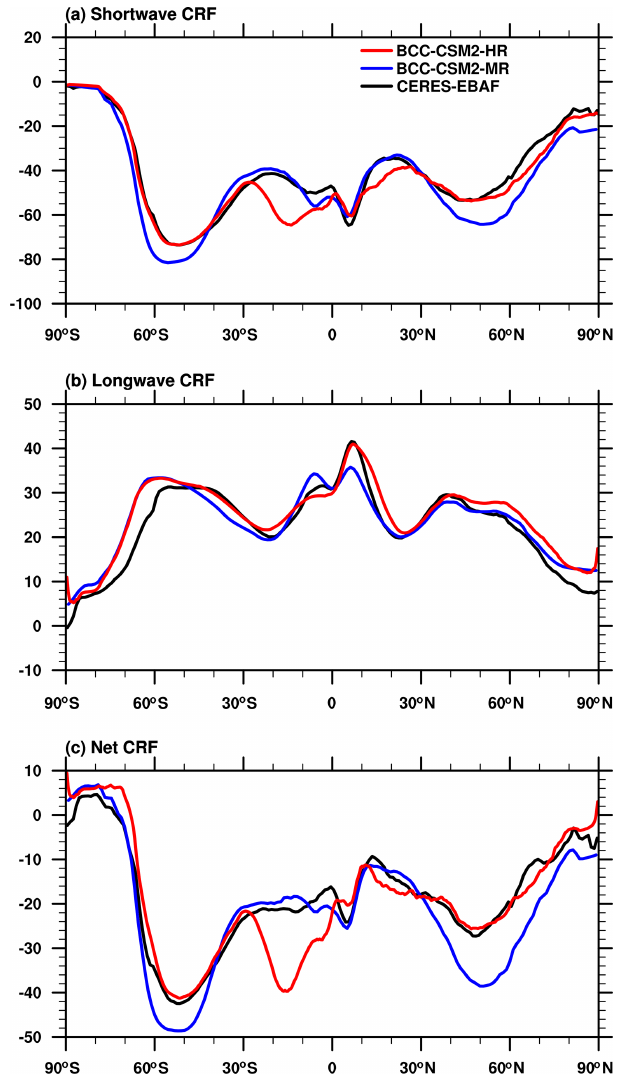
Figure 3. Zonal averages of (a) shortwave, (b) longwave, and (c) net cloud radiative forcing (CRF, in Wm − 2 ) for the historical sim- ulations (2001–2014) of BCC-CSM2-MR (blue lines) and BCC- CSM2-HR (red lines), compared to the 2001–2014 CERES-EBAF observations (black